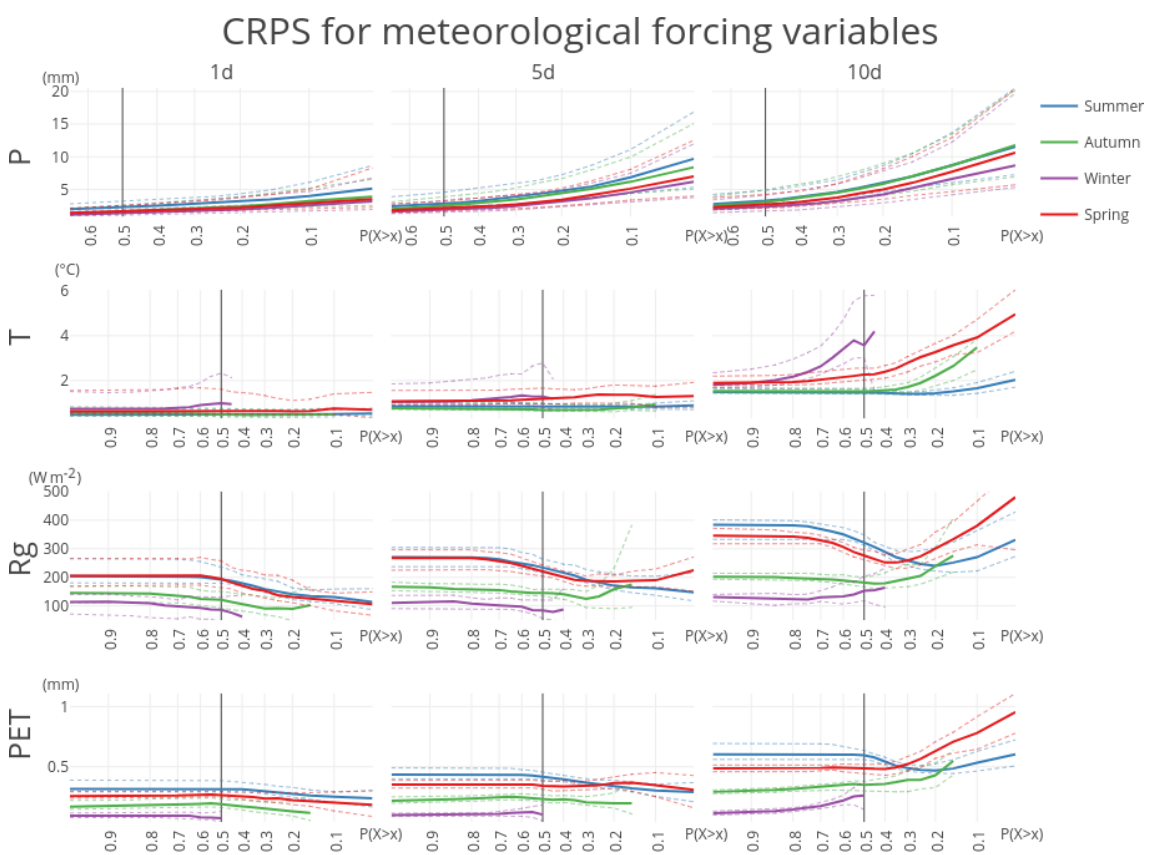
Figure 5. Continuous ranked probability score (CRPS) for the four forcing variables for the 148 HBV subbasins for the whole year. CRPS is aggregated into mean (solid), 10th and 90th percentiles (dashed). Note that the CRPS at P(X ≥ x) = 0 . 1 or 0.7 is calculated over, respectively, the 10% and 70% highest observation–forecast pairs, conditioned on the